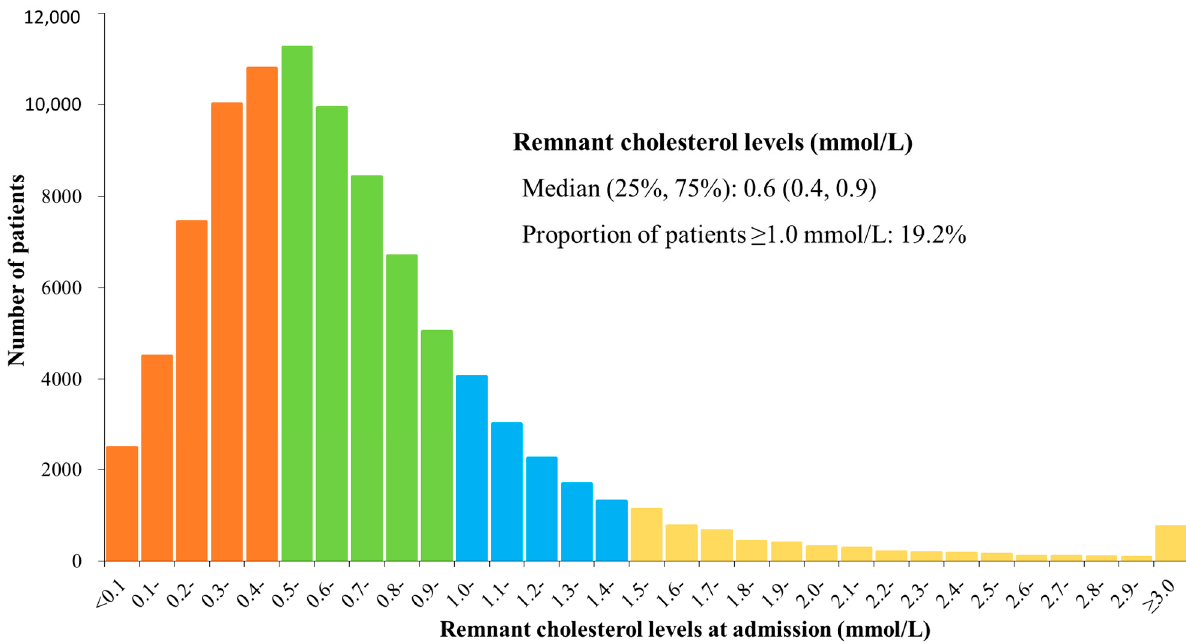
Figure 1. Distribution of remnant cholesterol concentrations at admission in patients with acute coronary syndrome.